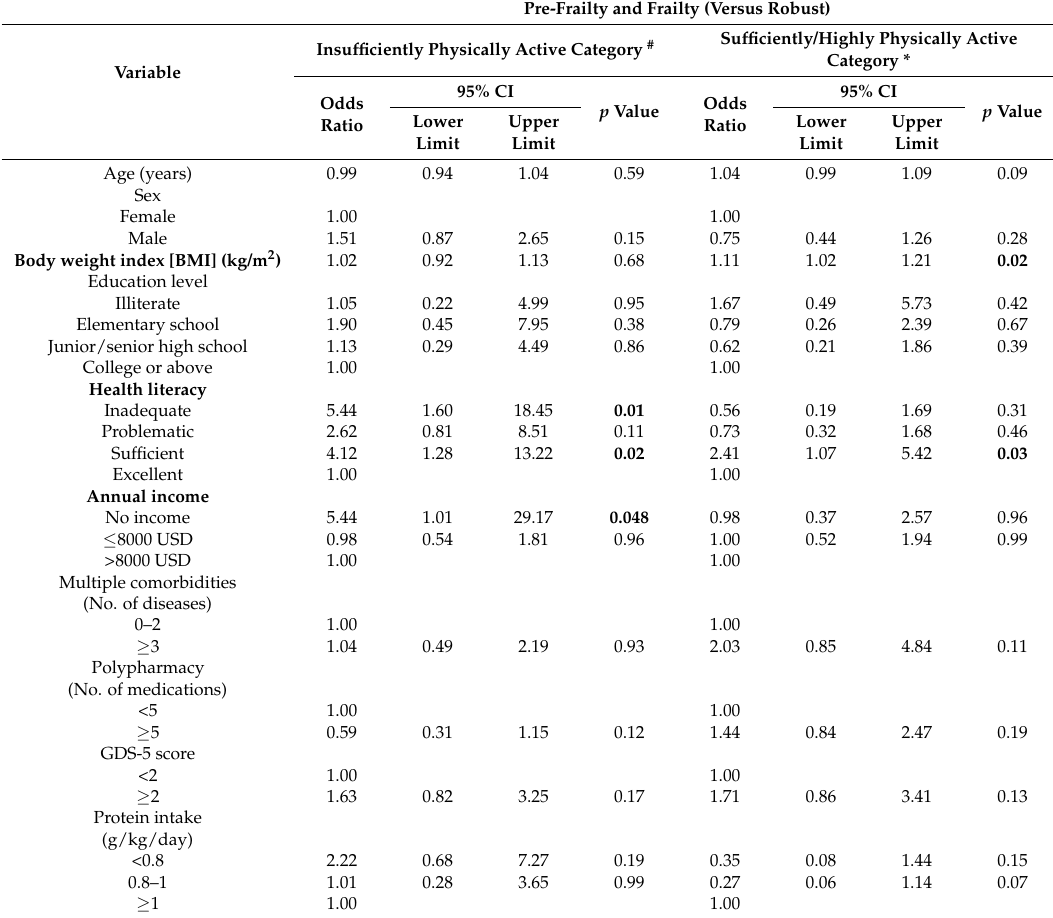
Table 4. Adjusted odds ratios for pre-frail and frail status by physical